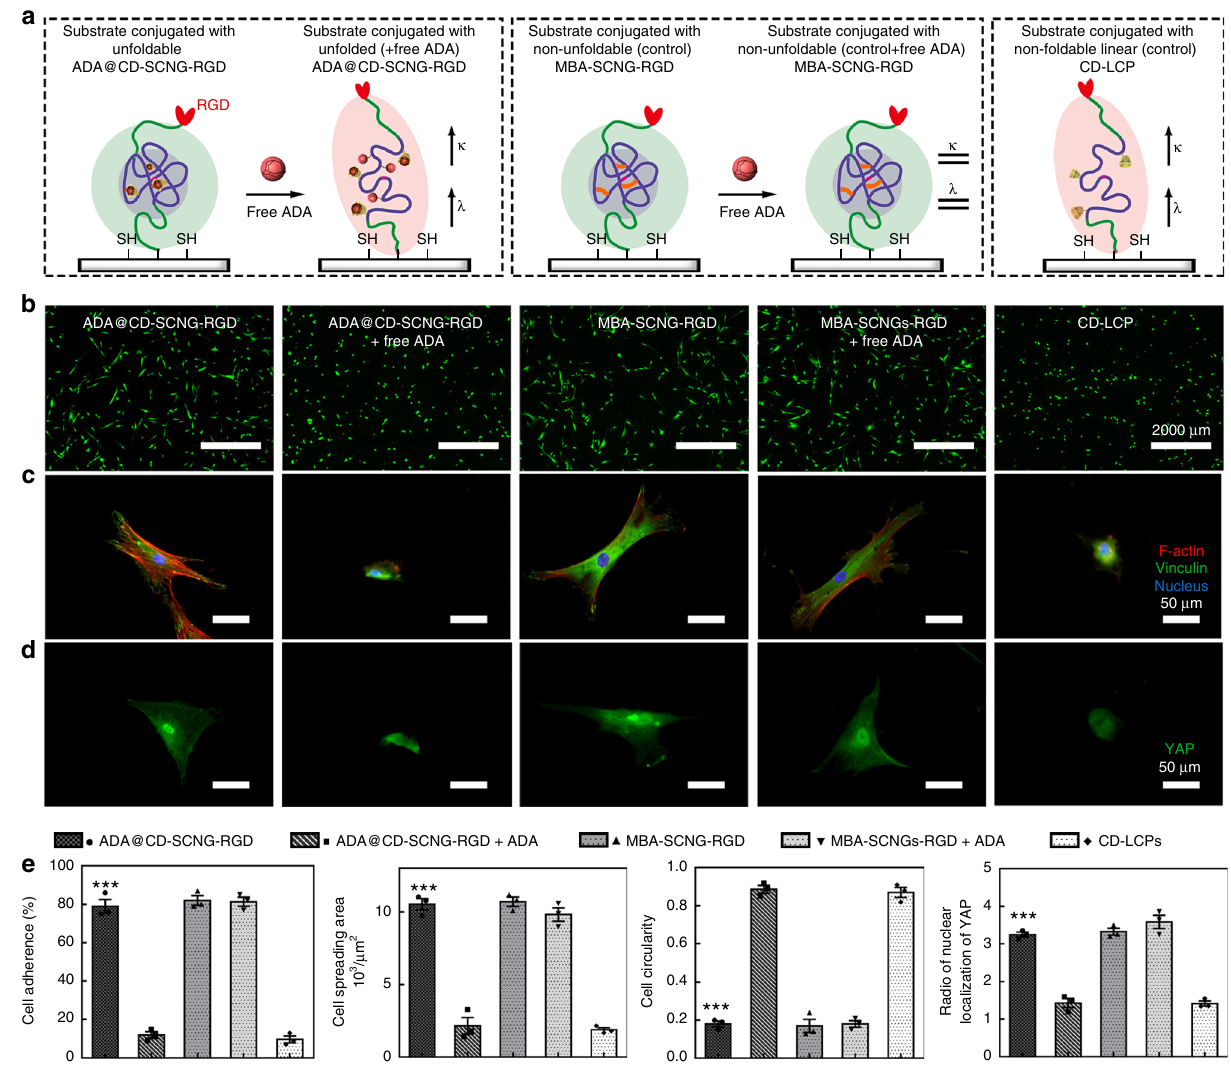
Fig. 5 Conformational change of the dynamic SCNG regulates the behaviour of stem cells. a Carton illustrations of the conformation of the RGD linker in each group. b Viability staining of living cells by calcein-AM shows that cells spread well on substrates conjugated with the folded ADA@CD-SCNG-RGD and MBA-SCNG-RGD linkers, whereas cells gradually detached and shrank in spreading size due to unfolding of the ADA@CD-SCNG-RGD linkers upon the addition of free ADA molecules. Scale bars are 2000 µ m. c Immunostaining of focal adhesion complexes (vinculin) and F-actin assembly, and d immunostaining of Yes-associated protein (YAP) for mechanosensing. Scale bars are 50 µ m. e Statistical analysis of cell adherence (the percentage of adherent cells out of total number of seeded cells), spreading area, circularity and nuclear localization of YAP for the groups in a . Data are means ± s.e.m. ( n = 3). * P < 0.05, ** P < 0.01, *** P < 0.001